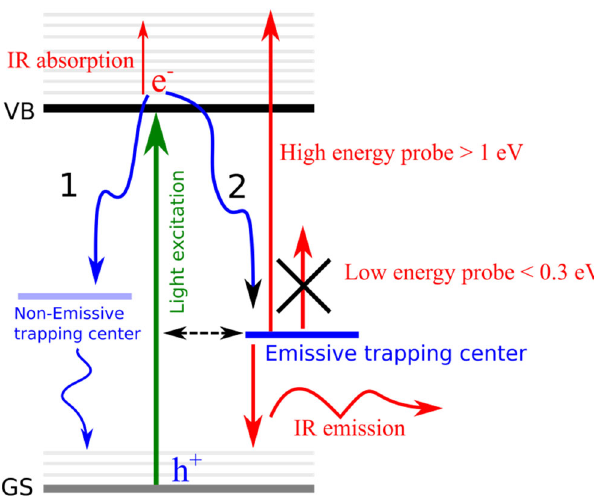
Fig. 5 The overall scheme. Schematic representation for the mechanism of charge recombination and charge trapping in various perovskite fi lms especially (MAPbI 3 ). See text for more